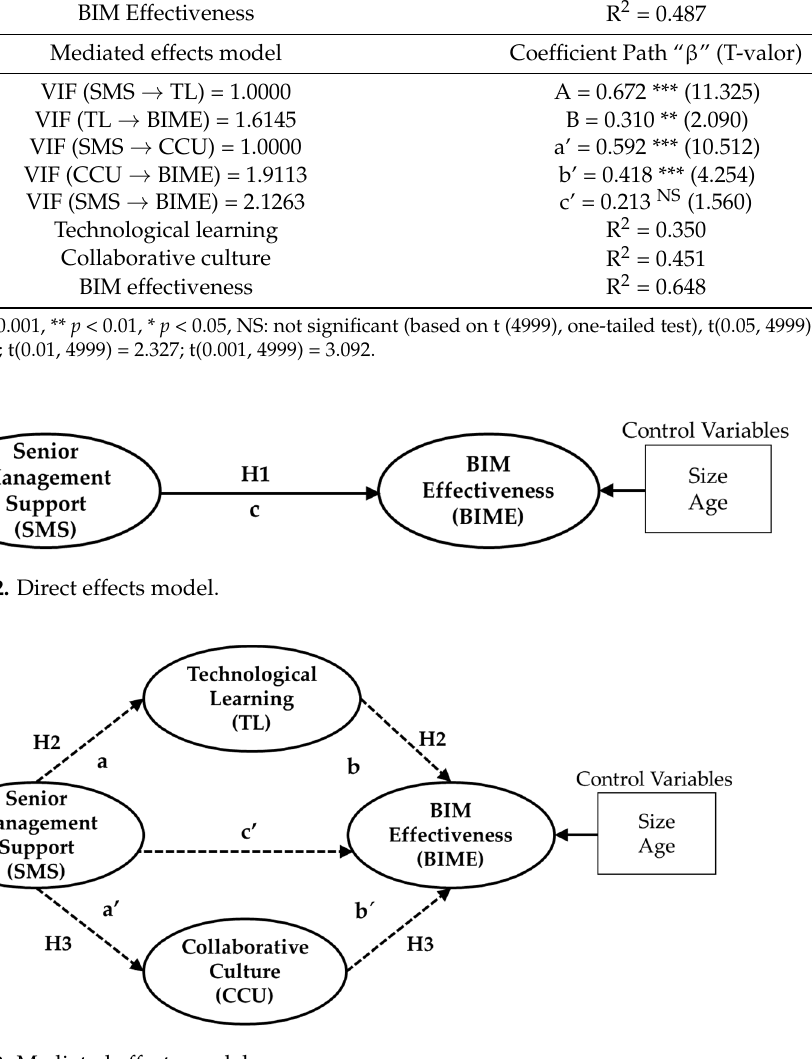
Table 4. Structural model results.